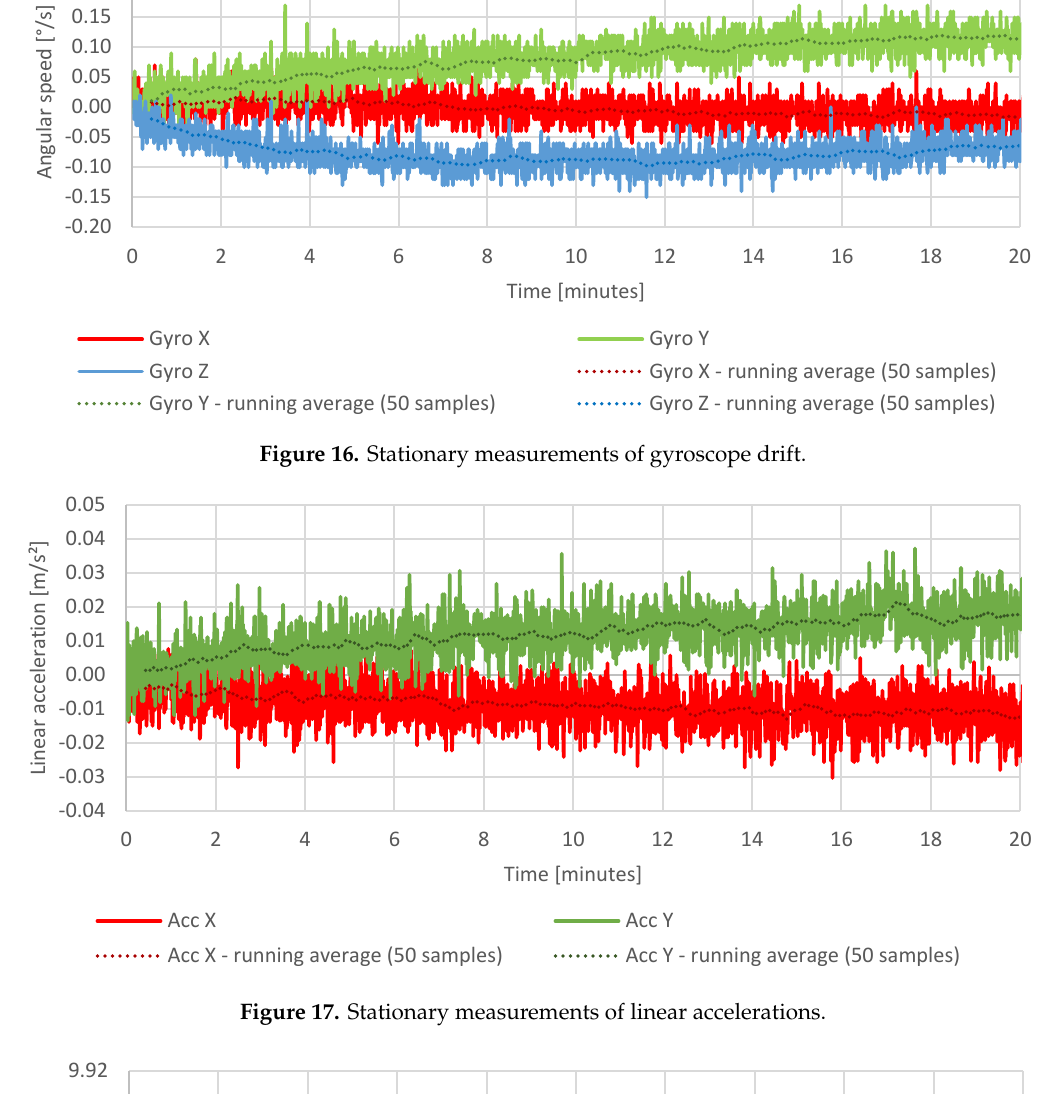
Figure 17. Stationary measurements of linear accelerations.